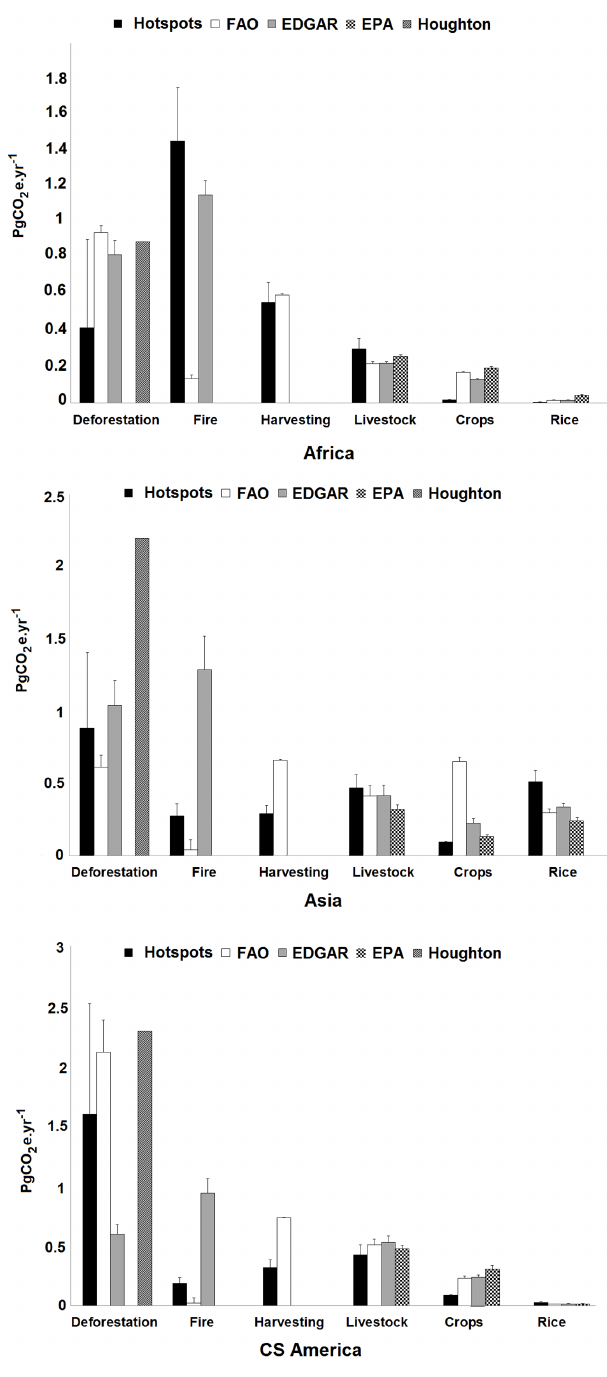
Figure 3. Continental disaggregated emissions for the individual emission sources (PgCO 2 eq.yr − 1 ) . Bars indicate uncertainty es- timates for the Hotspots dataset (1 σ from mean). No uncertainty estimates are available for the other datasets. Houghton data are net land use emissions (Forestry and Other Land Use) rather than de- forestation and are offered for visual comparison only. EPA covers agricultural emissions only (livestock, crops, and rice) and no forest